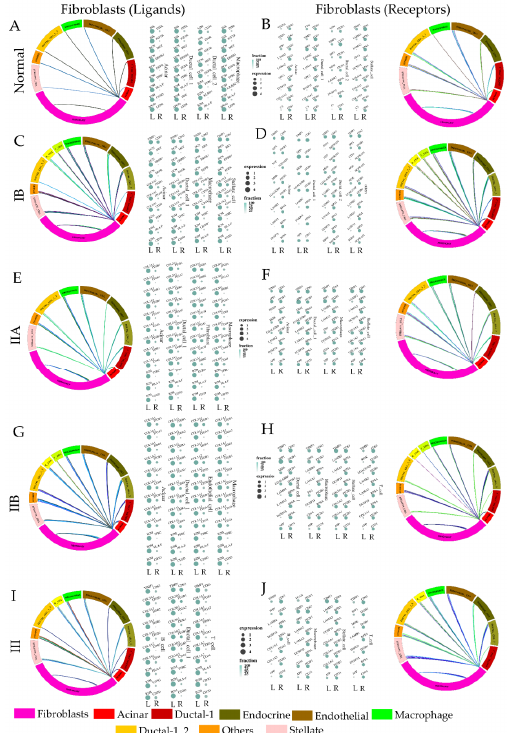
Figure 4. Mapping stage-wise ligand–receptor interactions of fibroblasts with other cell types in pancreatic ductal cell carcinoma. ( A ) Circos plot showing putative interaction of fibroblast-expressed ligand encoding genes in normal pancreas and their expressed cognate receptor genes in other cell types. Each cell type is represented by a different color shown in the figure legend. Interaction represents GO enrichment for type of ligand–receptor interaction between two cell types, each GO shown in different color, width representing strength of interaction. Additionally, the top 4 ligand-expressing genes in fibroblasts are shown with the expression of top 3 genes encoding potential cognate receptors in other cell types. The size of the bubble represents ligand expression. ( B ) Circos and bubble plots showing genes encoding receptors in fibroblasts from a normal pancreas and their putative ligand expression in other cell types; color scheme and other parameters similar to A. Ligand–receptor interactions between fibroblasts and other cell types with fibroblast-expressed ligands for ( C ) stage IB, ( E ) stage IIA, ( G ) stage IIB, and ( I ) stage III, and fibroblast-expressed receptors for ( D ) stage IB, ( F ) stage IIA, ( H ) stage IIB, and ( J ) stage III. For fibroblast-expressed ligands ( A , C , E , G , I ), the cut off used was: expression(ligand) ≥ 0.5, fraction of cells expressing ligand ≥ 5%, and ratio of genes in a given GO term for circos plot ≥ 9%. For fibroblast-expressed receptors ( B , D , F , H , J ), the cut off used was: expression(receptor) ≥ 0.5, fraction of cells expressing receptor ≥ 10%, and ratio of genes in a given GO term for circos plot ≥